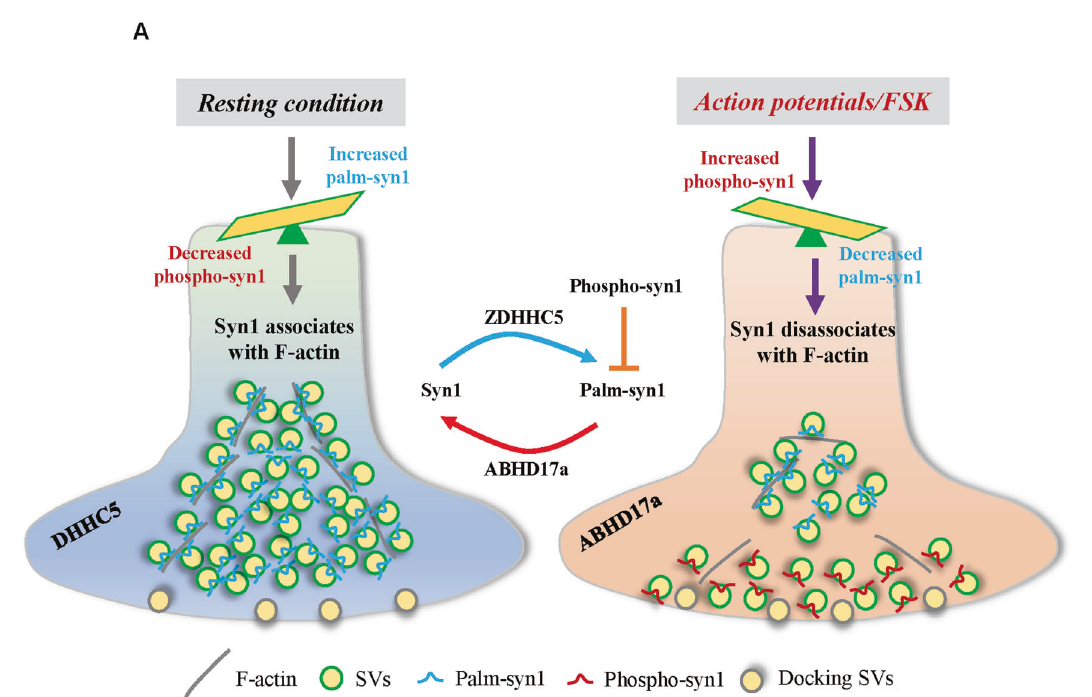
Fig. 7 Schematic presentation of SVs dynamicity regulated by the crosstalk of Syn1 palmitoylation and phosphorylation within presynapse. A under resting condition, downregulated Syn1 phosphorylation upregulates its level of palmitoylation mediated by ZDHHC5, together they ensure the high binding af fi nity of Syn1 with SVs and F-actin to maintain compacted SVs pool. In action potentiation (or triggered by FSK), Syn1 phosphorylation is upregulated, which then downregulates the level of palm-Syn1 potentially catalyzed by ABHD17a, together they trigger the disassociation of Syn1 with F-actin (partially) and thus the diffusion of SVs within presynapse. Of note, Syn1 phosphorylation negatively regulates its level of palmitoylation but not reversely. Moreover, the number of docking SVs are not affected within these